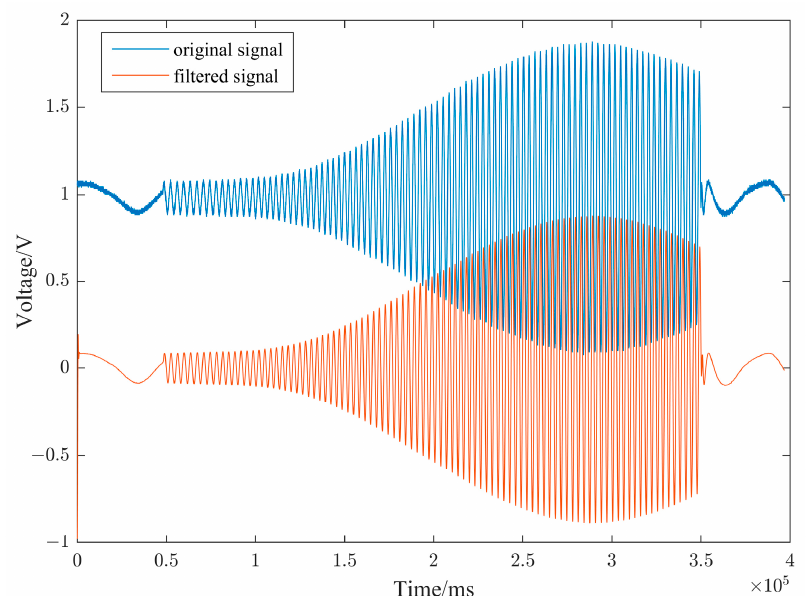
Figure 10. Original signal, and filtered signal with the direct-current light intensity subtracted. The phase difference measurement method requires the measured extrema to be ac- curate enough, and the measurement results are affected by noise. To reduce accidental error during the extremum measurement, at least five measurements are made for each output, and the two outputs are measured asynchronously. In the experiment, the DC light intensity of each output of the 1 × 2 beam splitter in the two outputs of the 2 × 2 coupler is approximately equal. According to the simulation results, the difference between the adjacent maximum or minimum of the normalized interference term I ∆ is about | I ∆ | max a 0 = 0.023, and the light intensity difference between the adjacent maximum or minimum n (cid:113) ∆ a 0 | I ∆ | I (cid:48) I (cid:48) points is ∆ = 2 . When the light intensity difference ∆ between the extrema n max 2 1 is greater relative to the detector noise, the measurement results are obviously more accu- rate. Let the signal-to-noise ratio (SNR) be ∆ divided by the detector noise (3.5 pW). The experimental results of two groups with different SNRs are shown below. Table 1 shows the estimated SNR for the two sets of measured data, and | I ∆ | in the table does not reach max 1, which is mainly caused by